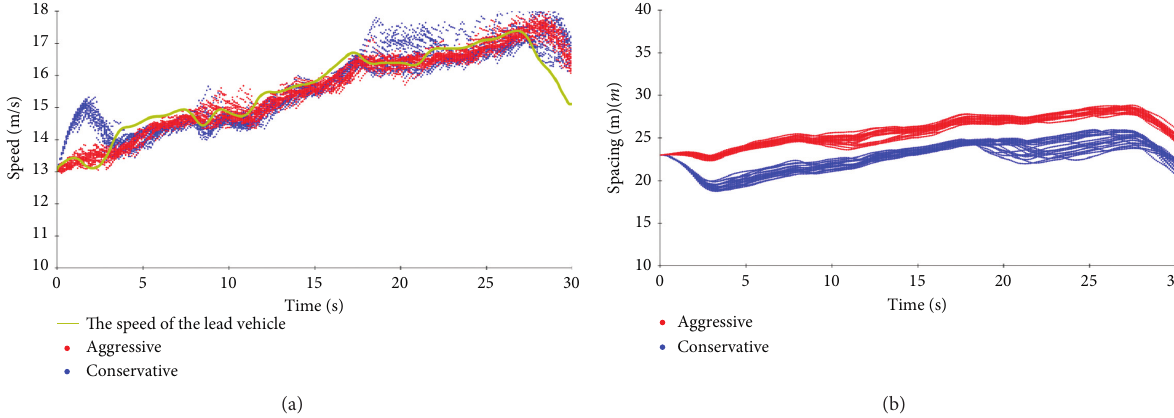
Figure 10: Comparison of the strategies of the two groups with different driving styles. (a) and (b) are the simulation results of speed and spacing,